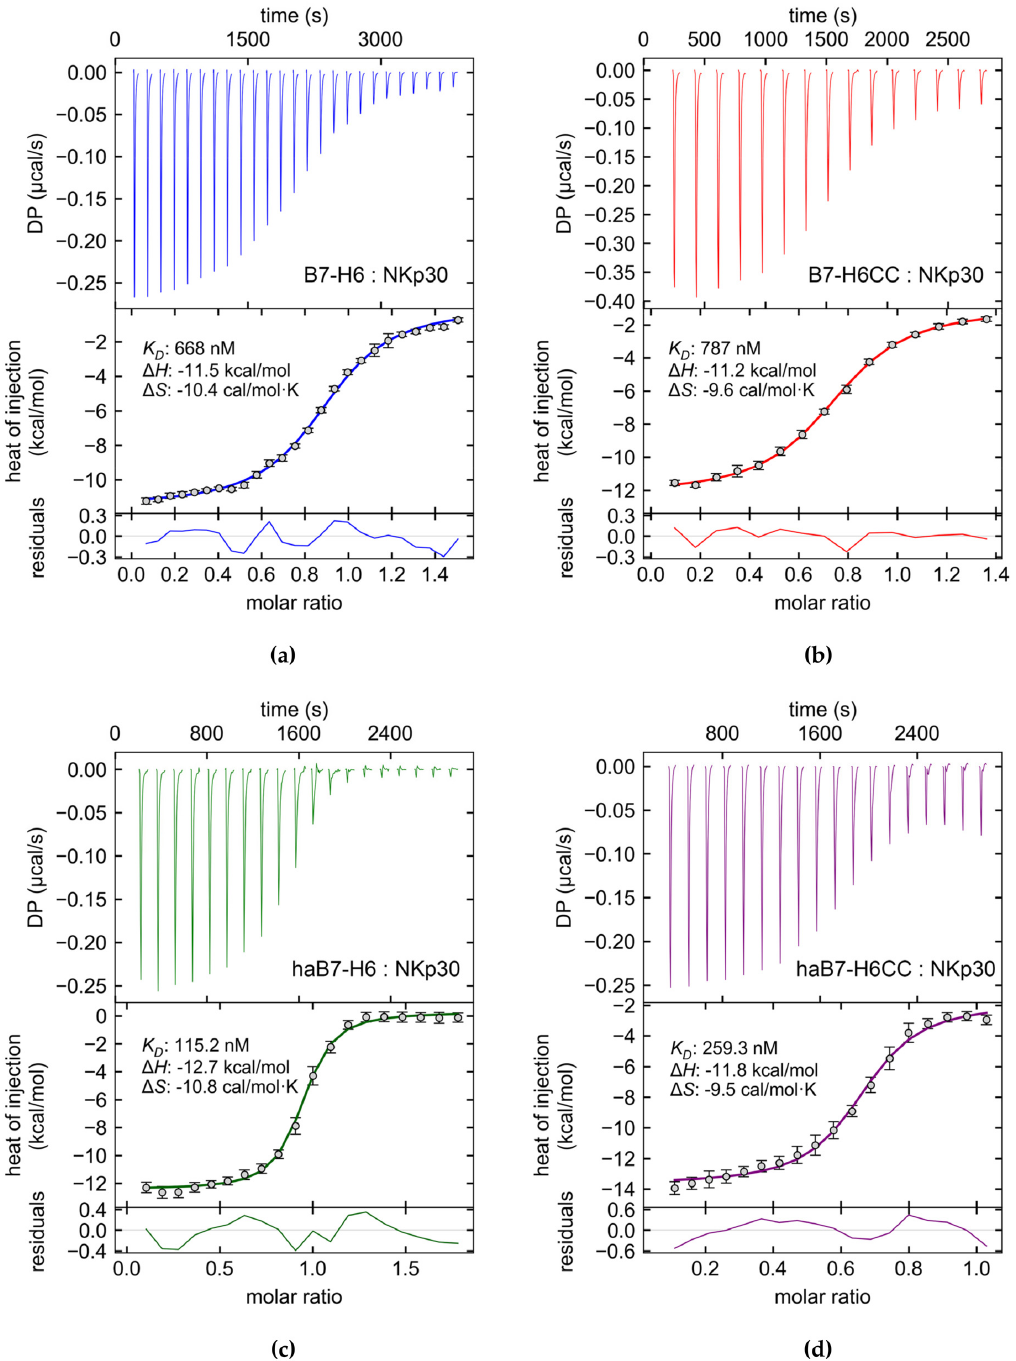
Figure 2. Wild-type and coiled coil B7-H6 proteins bind NKp30 receptor with comparable affinity. The binding of ( a ) wild- type B7-H6 or ( b ) its coiled coil variant to the NKp30 receptor was compared by isothermal titration calorimetry, confirming that adding the coiled coil sequence to the C-terminus of B7-H6 does not substantially alter its binding properties in solution. Next, haB7-H6 ( c ) and haB7-H6CC ( d ) high-affinity B7-H6 constructs were analyzed to assess whether the previously reported mutations indeed increase the affinity. For haB7-H6, the affinity was almost six-fold higher compared to wild-type B7-H6, but more than ten times lower than published previously for the affinity-matured B7-H6 IgG1 SEED fusion constructs [71]. Similarly to B7-H6CC, we observed lower stoichiometry and affinity values for the haB7-H6CC than for the untagged